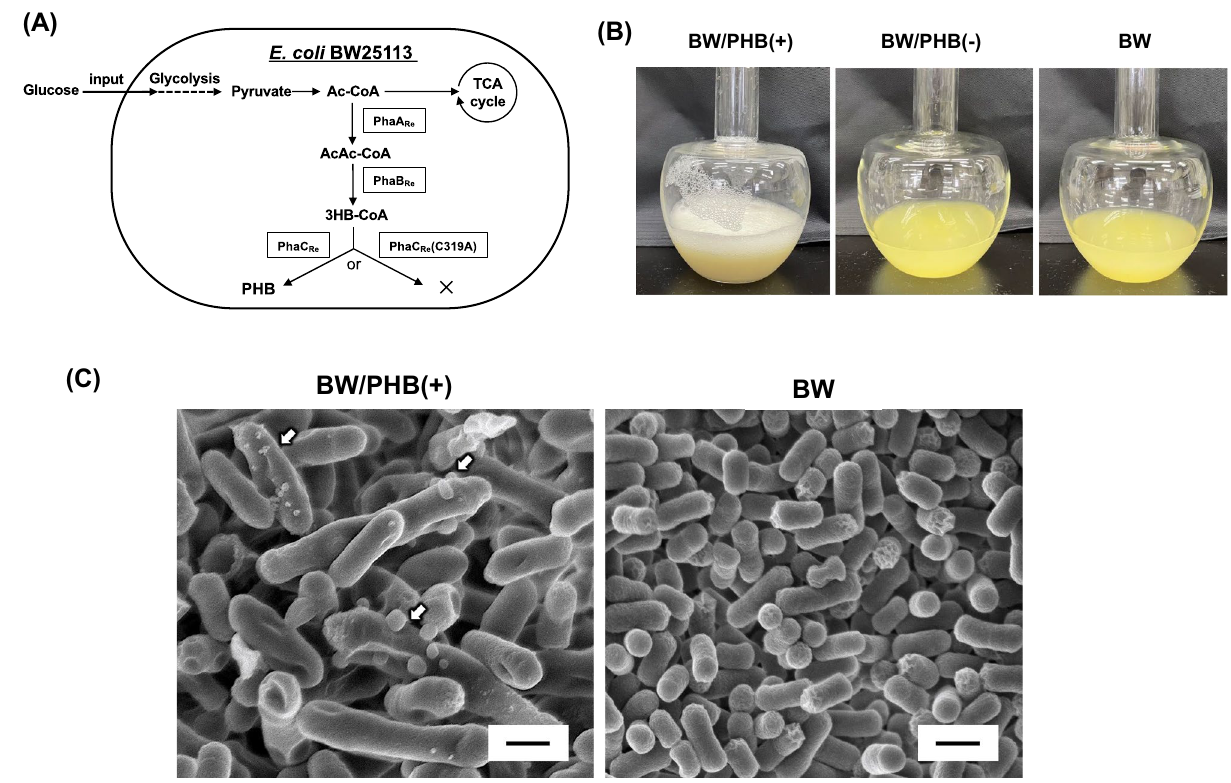
Figure 1. The primary findings of MV biogenesis in E. coli producing PHB. ( A ) Schematic illustration of a metabolic pathway for production of PHB. Acetyl-CoA (Ac-CoA) supplied from glucose via glycolysis is converted into acetoacetyl-CoA (AcAc-CoA) through function of heterologously expressed PhaA Re . AcAc-CoA is converted into 3-hydroxybutyrate-CoA (3HB-CoA) through function of PhaB Re . 3HB-CoA is utilized as a monomer for the polymerization by PhaC Re . When the inactive mutant PhaC(C319A) is replaced to PhaC Re , the production of PHB is not observed. ( B ) The foam observed during cultivation. ( C ) SEM images of the cell surface of three recombinant constructs: BW/PHB (+), BW/PHB (−) and BW. Black arrowheads denote MV-like particles budded from the cell surface. Scale bars represent 1